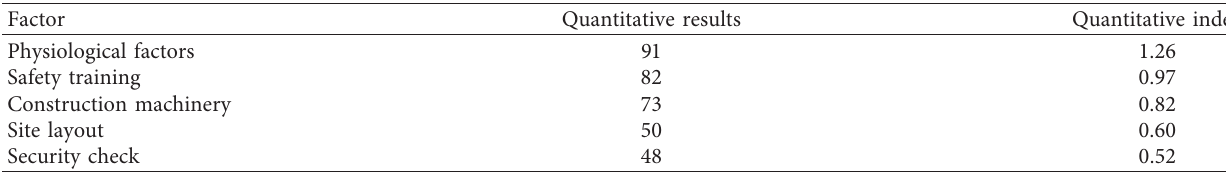
Table 5: Single factor index data quantification processing